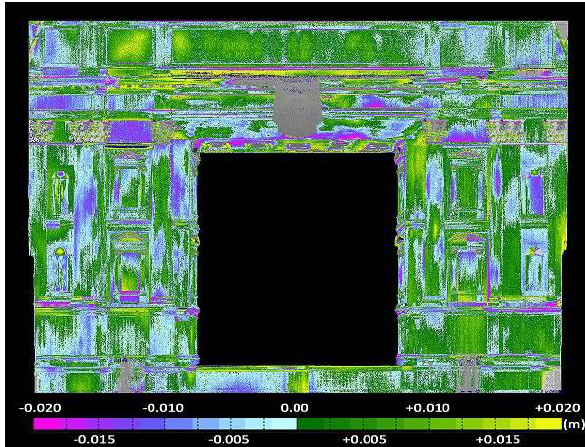
Figure 5 . Comparison map (m) between the TLS point cloud and the 3D model of the proscenium.